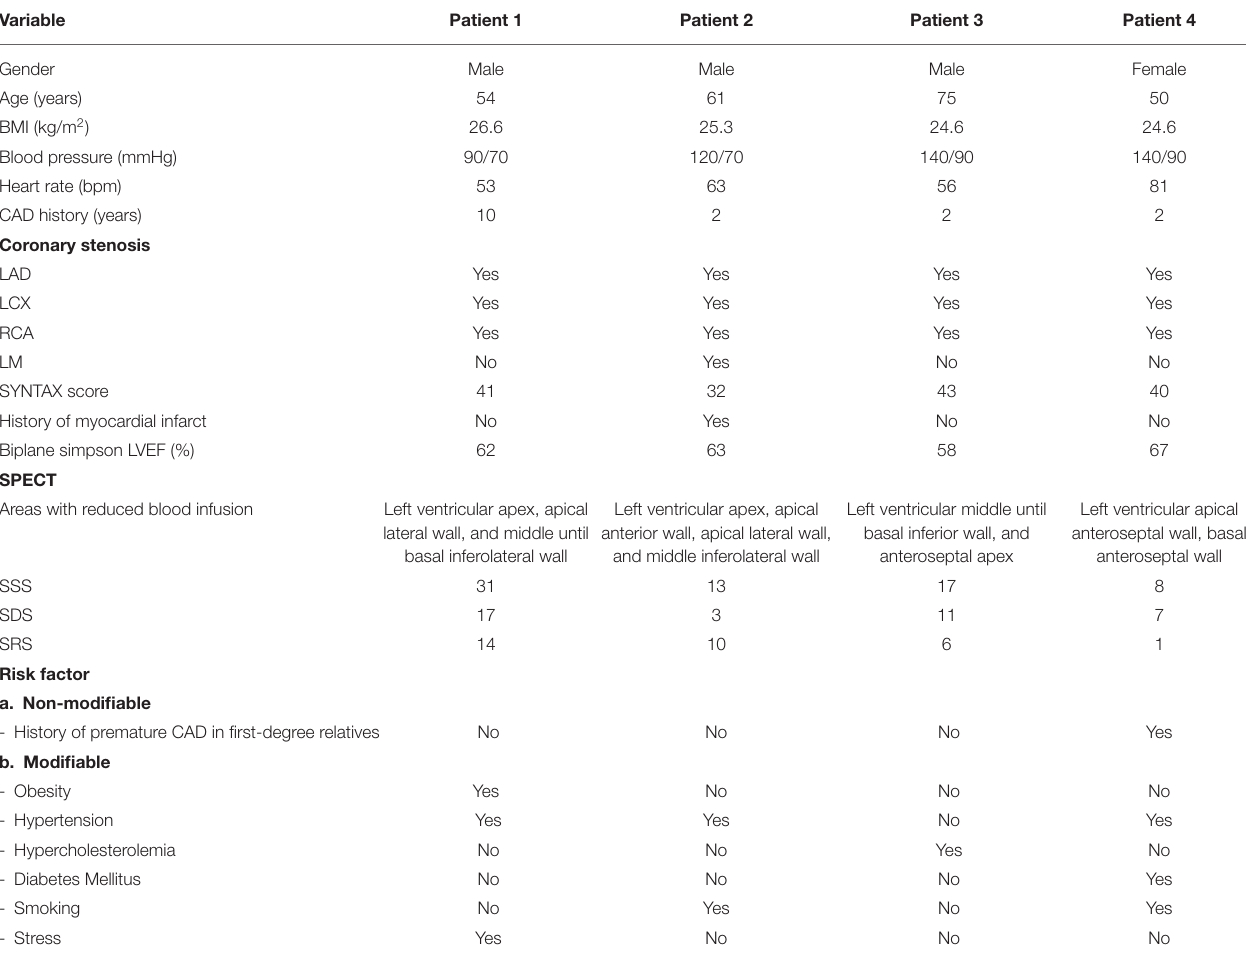
TABLE 1 | Included patients characteristics.